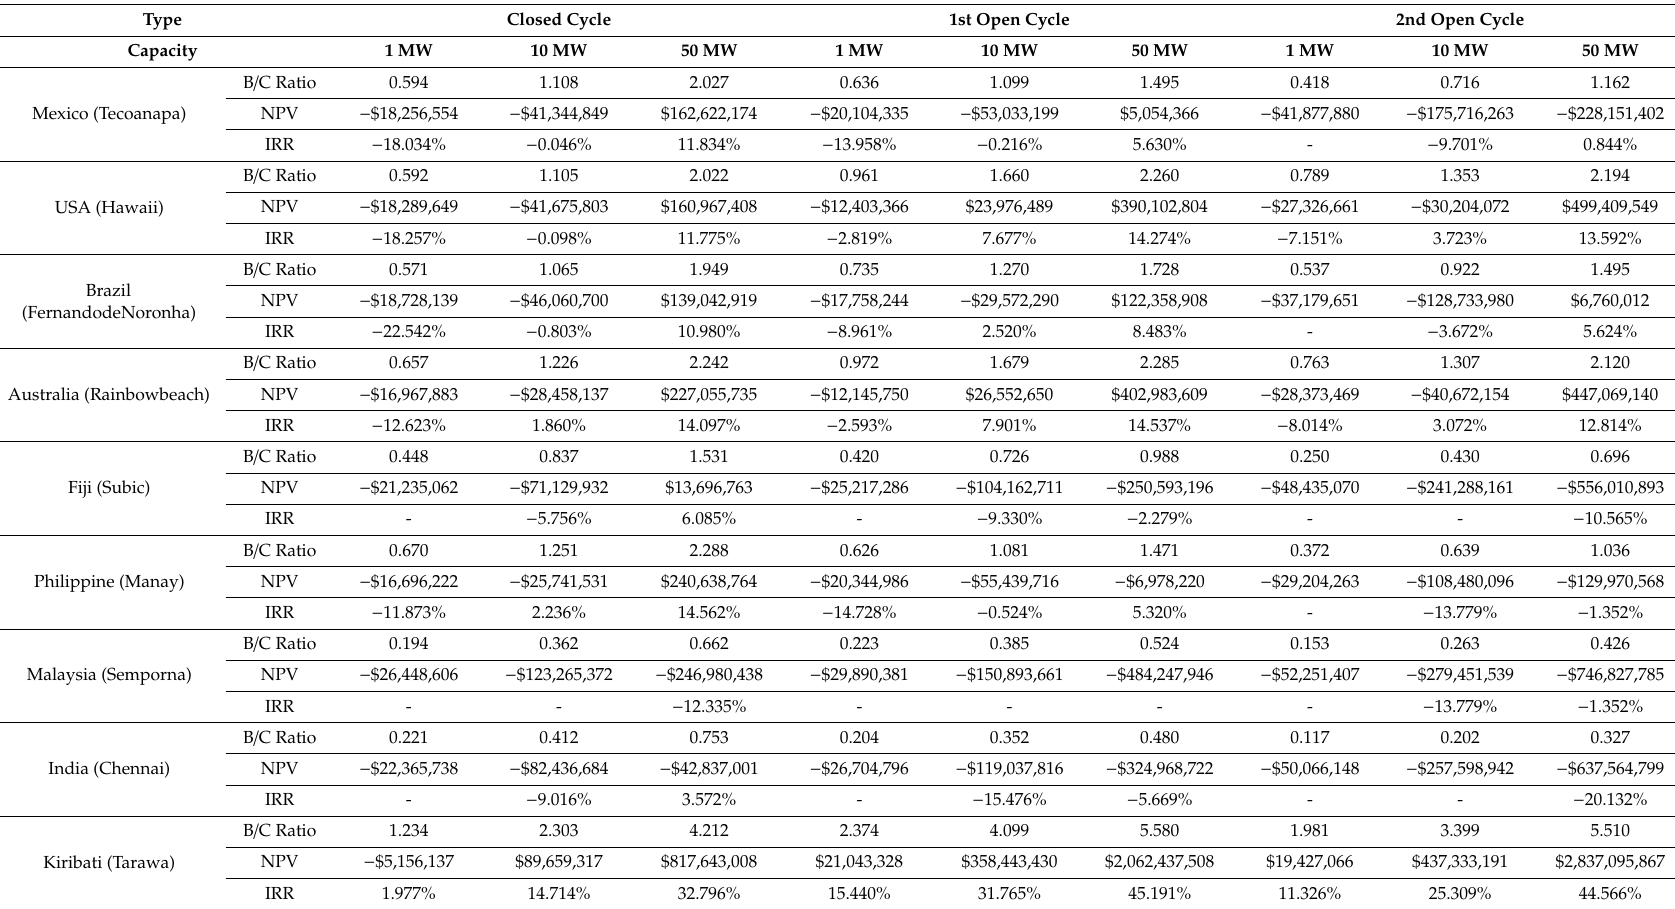
Table 6. Economic analysis according to OTEC’s capacity with 15% decrease in initial investment